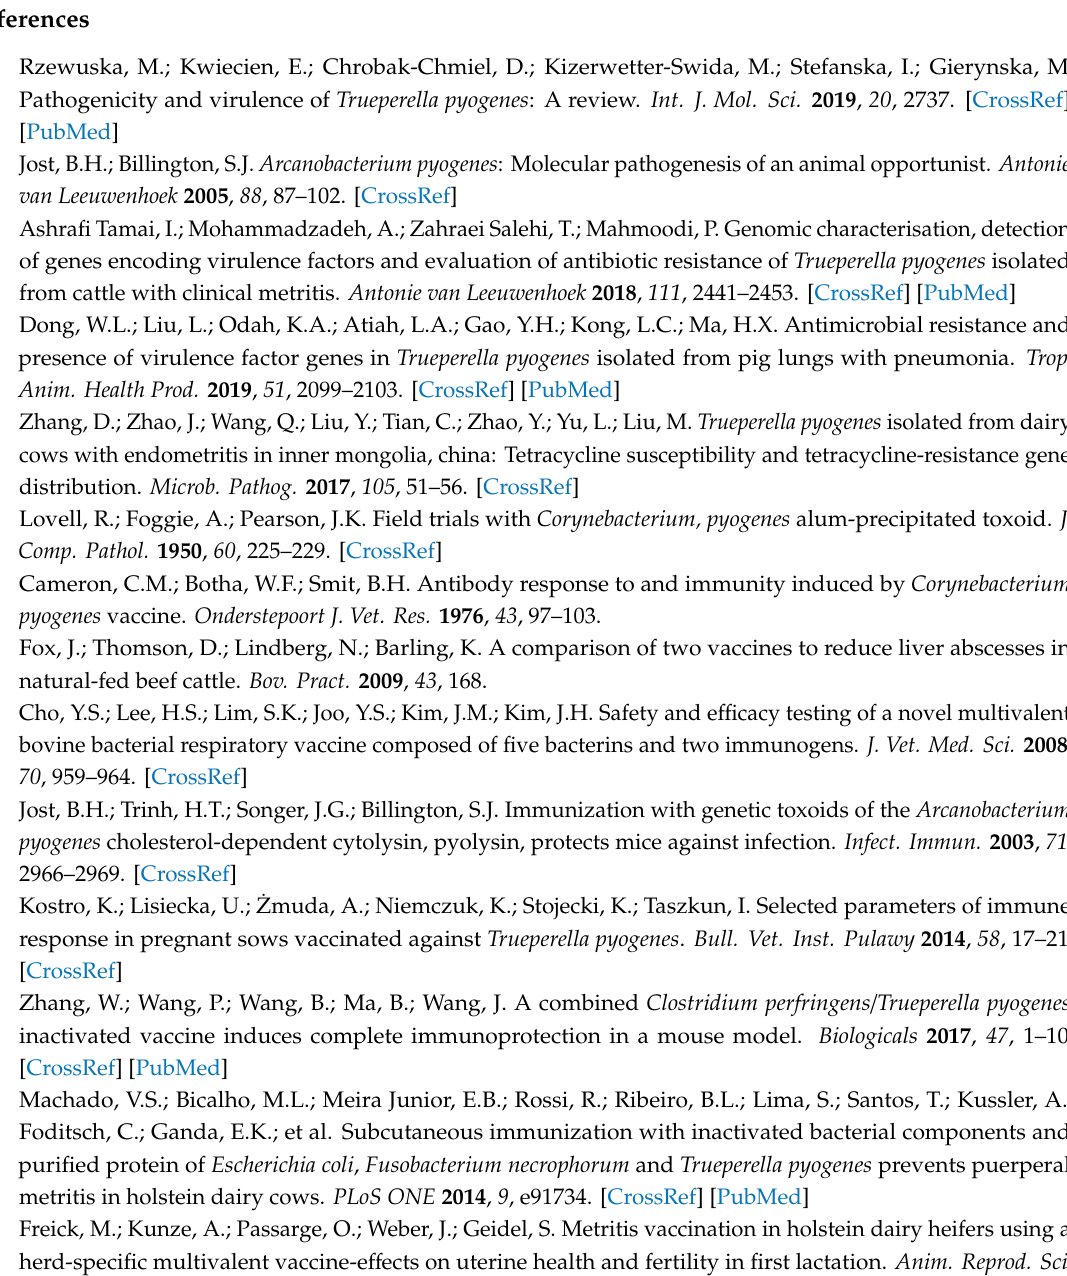
Figure S1: Strategy for the construction of recombinant expression plasmids, Figure S2: Scheme of animal immunization and challenge experiment, Figure S3: Determination of the cell membrane binding capacity of rPLO D123 and rPLO